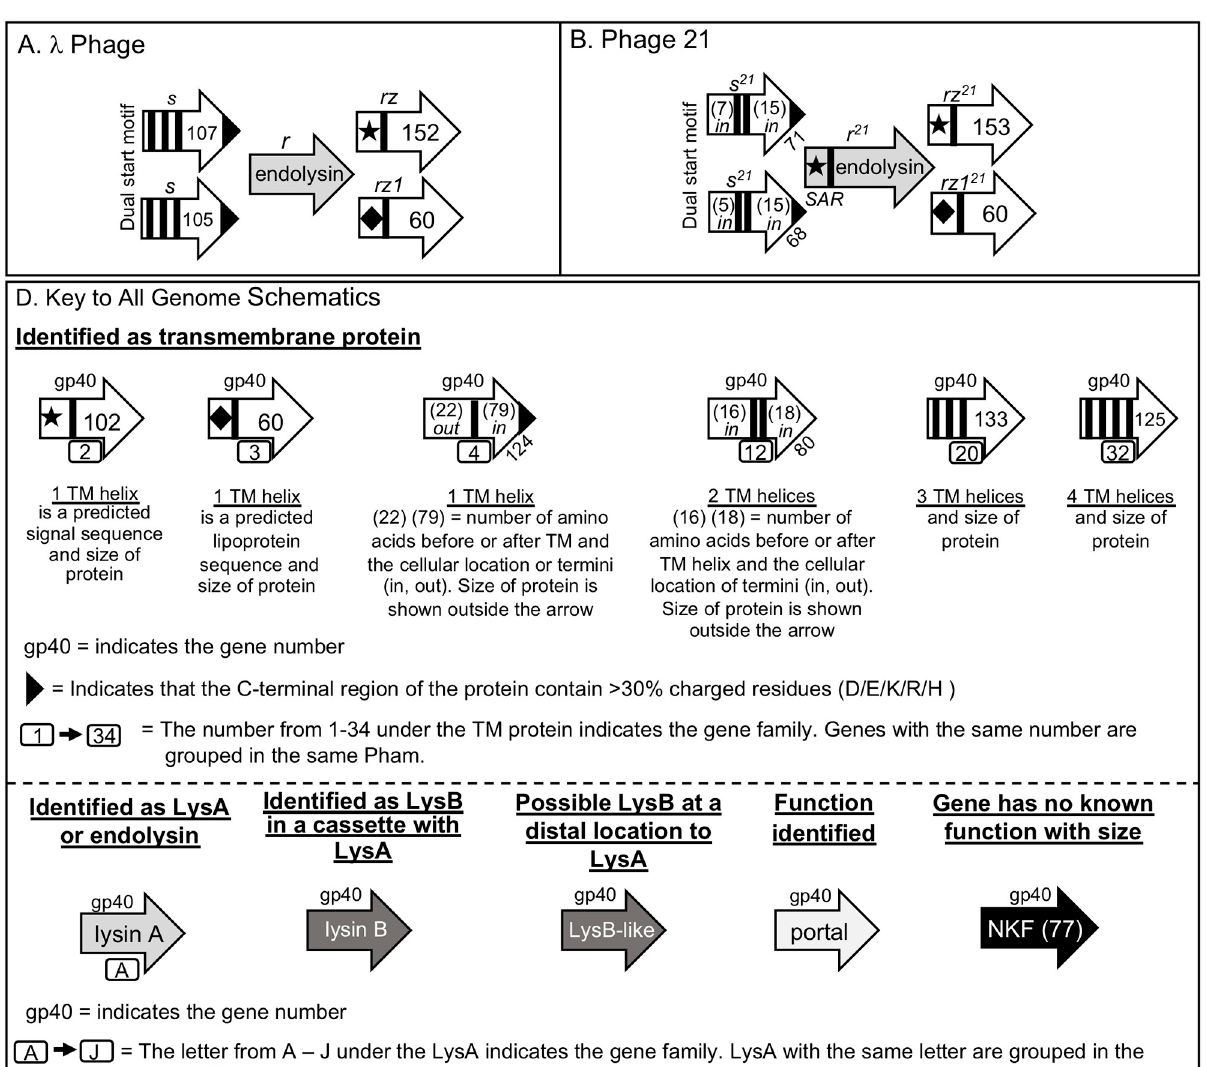
Fig 1. Proteins within the lysis cassettes of phages that infect Gram negative bacteria and key to genome schematics. Panel A: the lysis cassette proteins from λ phage. Panel B: the lysis cassette proteins from phage 21. The direction of transcription of the gene is represented by the arrowhead. The identity of each protein is shown above the arrow. Panel D. The key to all of the genome organization schematics within this report. Note that the Pham designation for the LysA and holin-like genes is represented by a letter or number so that proteins that are grouped together can be readily identified. The corresponding genes can also be found in Tables 2 and